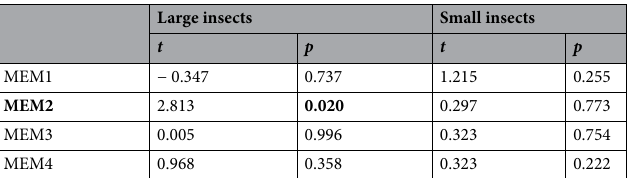
Table 3. Results of multiple regression analysis relating seed set of buckwheat to spatial variables represented by four MEM axes (Moran’s Eigenvector Map). The analysis was conducted separately for seed set contribution of large and small insects. The variable with a bold letter indicates statistical